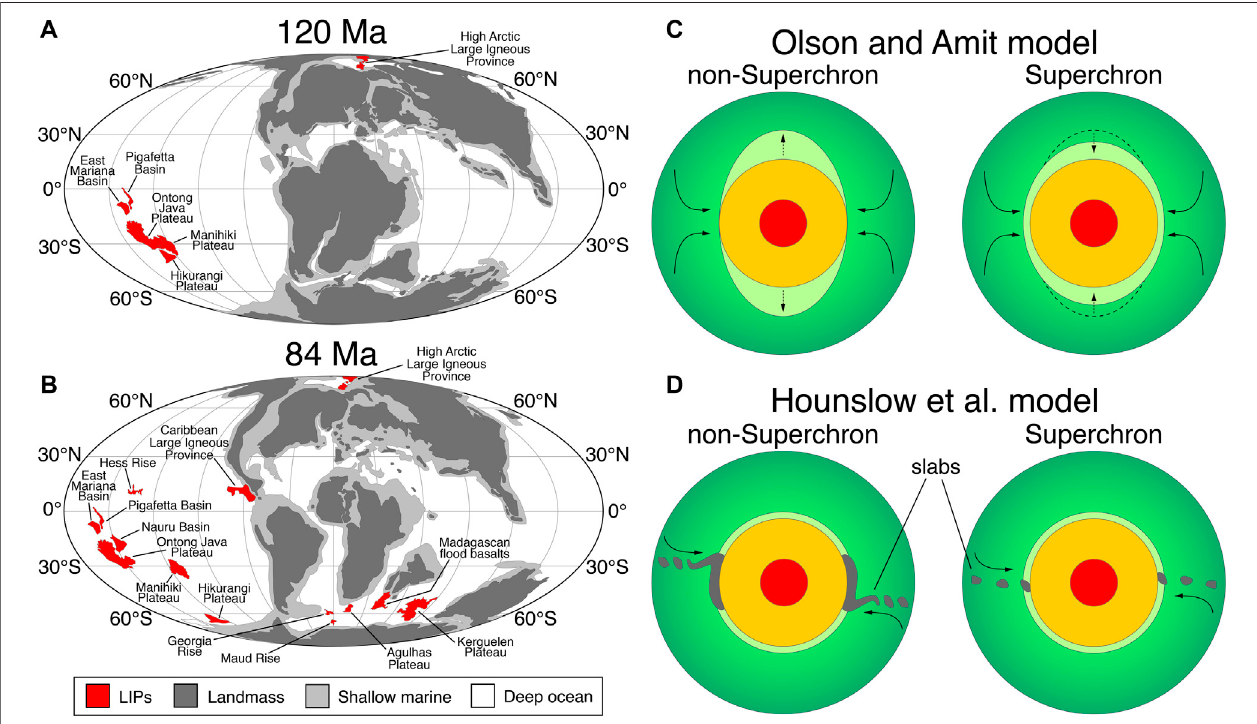
FIGURE 2 | (A,B) Distribution of Large Igneous Provinces at 120 Ma (A) and 84 Ma (B) with paleogeography based on Johansson et al. (2018), which erupted during the CNS. LIPs, Large Igneous Provinces. (C,D) Two hypotheses for the cause of the CNS. (C) Equatorial cross-sections of the core (red and orange) and lower mantle (green) illustrating superplume growth and collapse in the D ″ -region (light green) above the core-mantle boundary based on Olson and Amit (2015). Arrows indicatethelowermantlecirculationpatterns.SuperplumegrowththinstheD ″ -regionbelowlowermantledownwelling,whichincreasestheheat fl uxaverageatthe core-mantle boundary. The geodynamo expresses a higher geomagnetic reversal frequency at that time. On the contrary, superplume collapses reduces the heat fl ux average at the core-mantle boundary and reduce reversal frequency, which is Superchron. (D) Cross-sections of the core (red and orange) and lower mantle (green) illustrating changing of the subduction fl ux (the volume of slabs) based on Hounslow et al. (2018), which reaches the D ″ layer (light green) above the core-mantle boundary. Higher subduction fl ux increases the volume of slabs reaching the D ″ layer, increases the heat fl ux average at the core-mantle boundary, and increases geomagnetic reversal frequency. On the contrary, lower subduction fl ux reduces the volume of slabs reaching the D ″ layer, reduces the heat fl ux average at the core- mantle boundary, and reduces reversal frequency, which is Superchron.